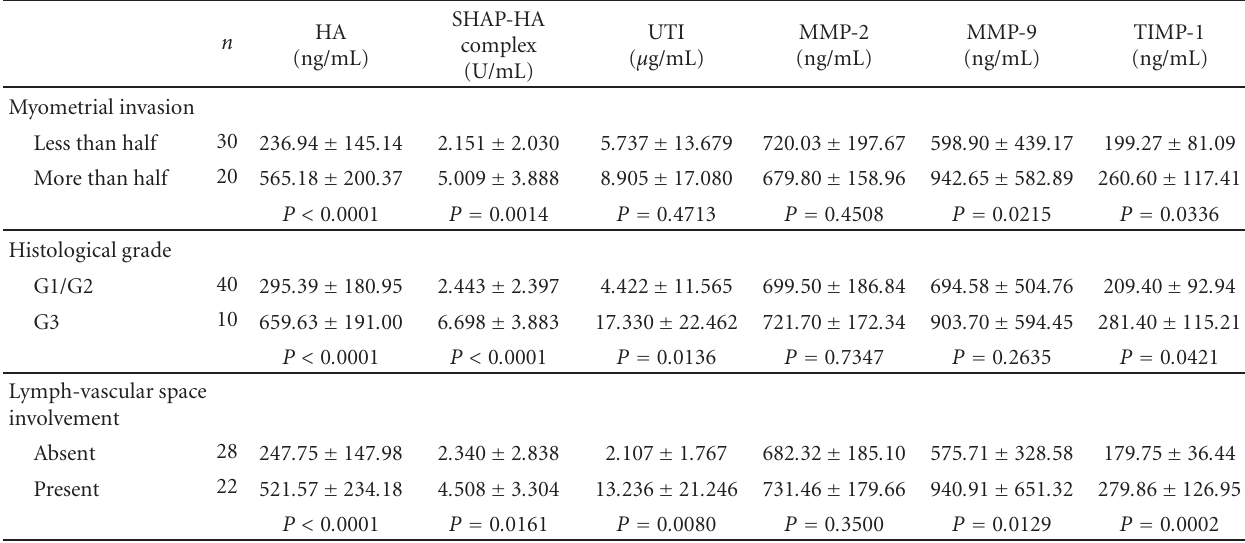
Table 3: Serum HA, SHAP-HA complex, MMP-2, MMP-9, TIMP-1, and UTI in relation to the depth of myometrial invasion, histological grade, and lymph-vascular space involvement in patients with endometrial cancer.